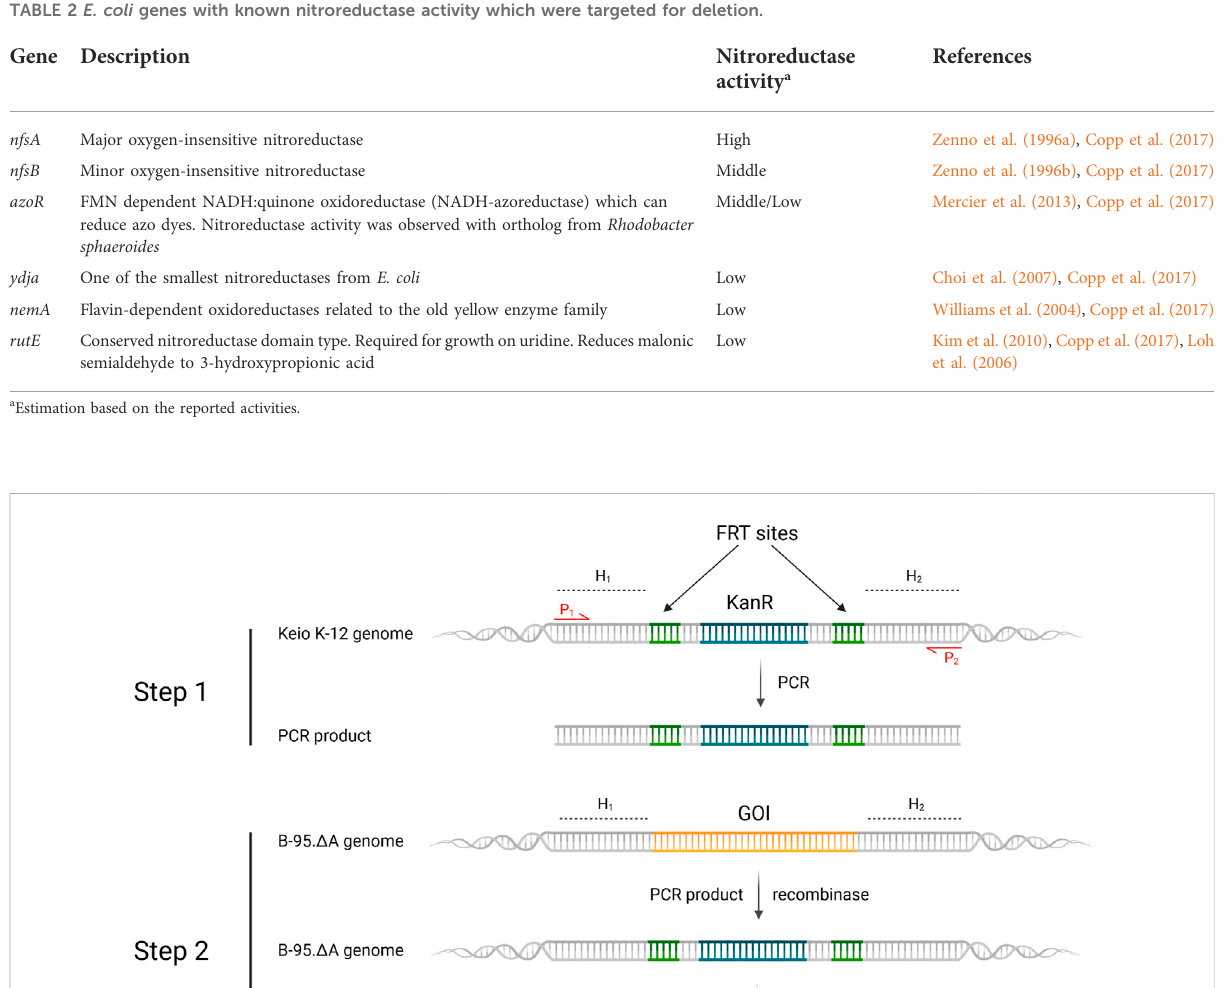
TABLE 2 E. coli genes with known nitroreductase activity which were targeted for deletion.